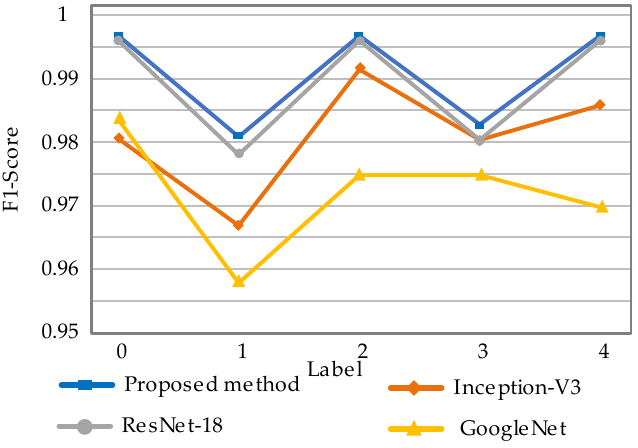
Figure 16. F1-score for different labels. The training time of the optimal BayesianPDL framework is compared with that of GoogleNet, ResNet-18, and Inception-V3, methods. The efficiency of raw vibration signal input into different diagnostic methods is shown in Table 4. As the number of PFRBs increases, the training time of the BayesianPDL framework continues to increase. However, the accuracy is highest when the BayesianPDL framework has three PFRBs. Other diagnostic methods have a long training time due to the complex network structure. The proposed method has high accuracy and the shortest training time. Table 4. The diagnostic performance of the different